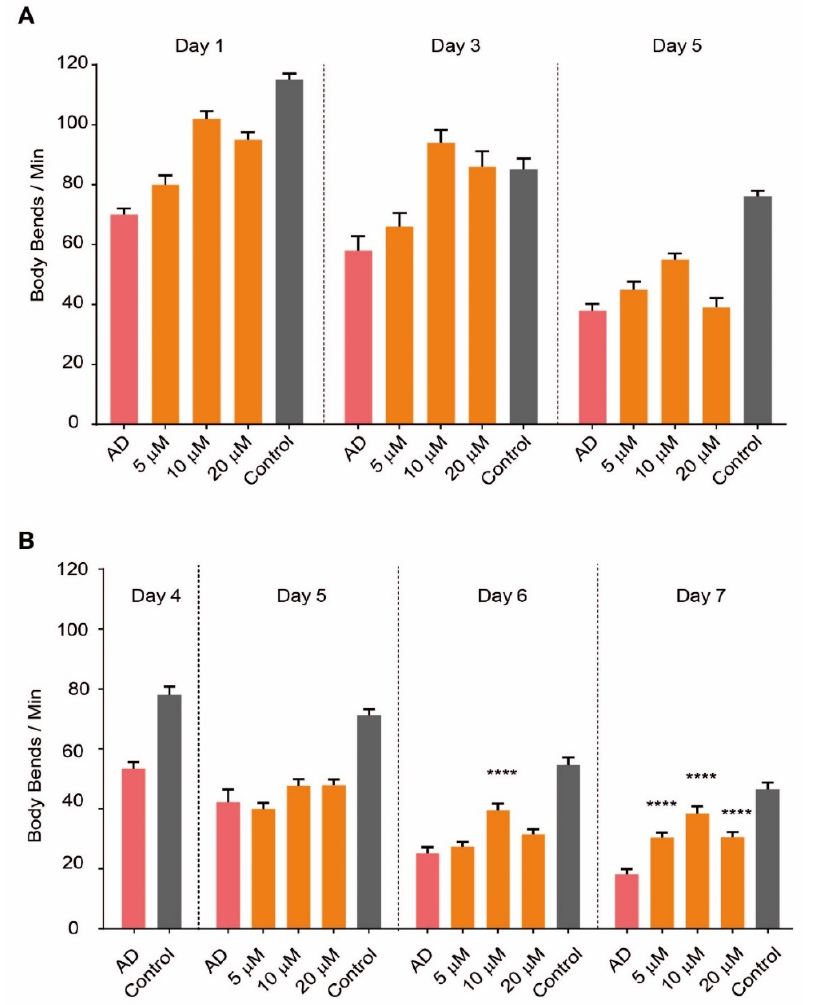
Figure 1. SG2 recovers fitness in a C. elegans model of AD. SG2 was administered to the worms following two different treatment regimes, namely early treatment at D0 ( A ) or late treatment at D4 ( B ). SG2 dosed at 5, 10 and 20 µM showed significant dose-dependent recovery effect, expressed as body bends/min, on AD worms ( A , B ). Error bars represent the standard error of the mean (SEM). For statistical tests, One-Way ANOVA was used. p ≤ 0.0001 (****).